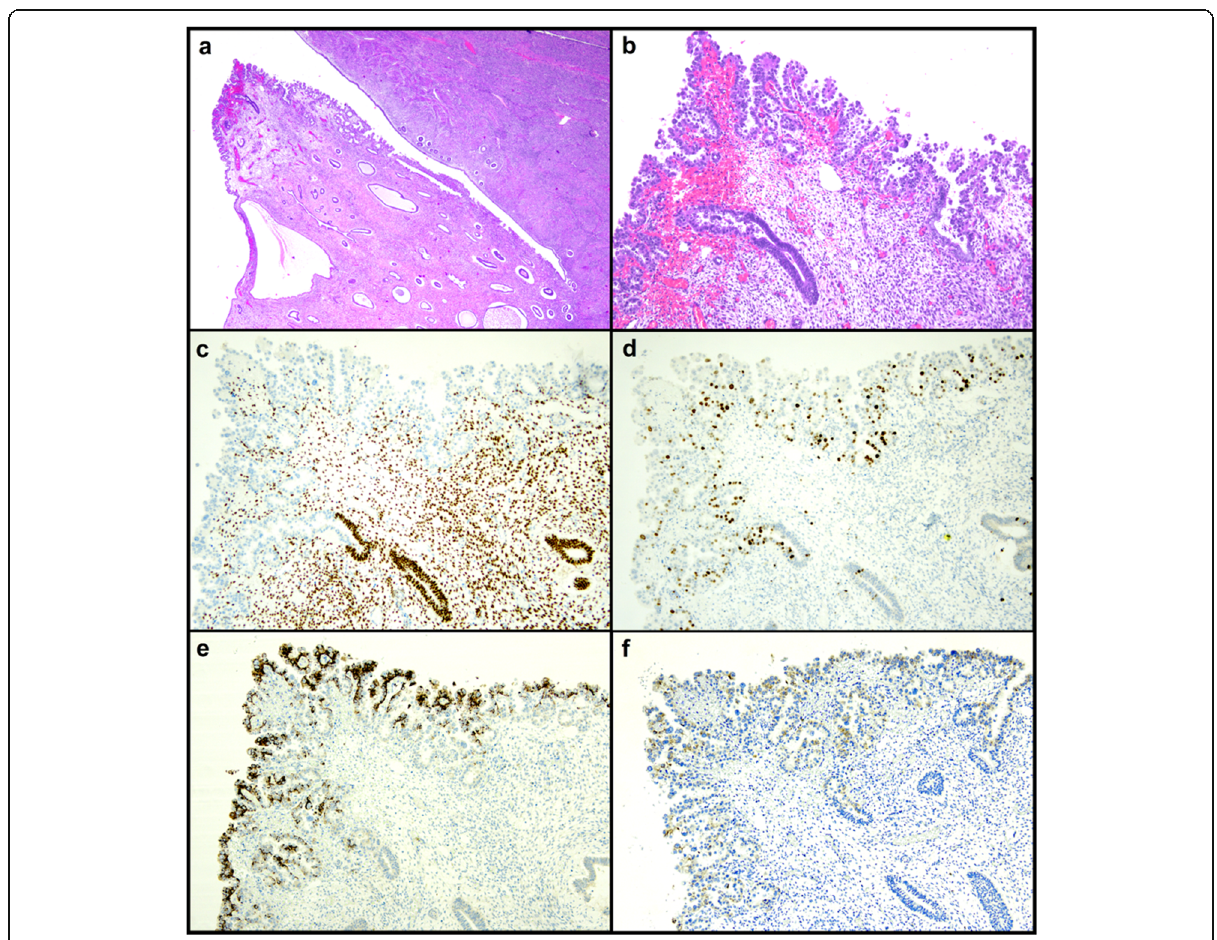
Fig. 1 Case 1. Clear cell endometrial intraepithelial carcinoma on the surface of an endometrial polyp. Hematoxylin-eosin at 40X ( a ) and 200X ( b ) magnification. Immunohistochemical stain for estrogen receptor ( c ), Ki67 ( d ), Napsin A ( e ) and AMACR ( f ) (magnification